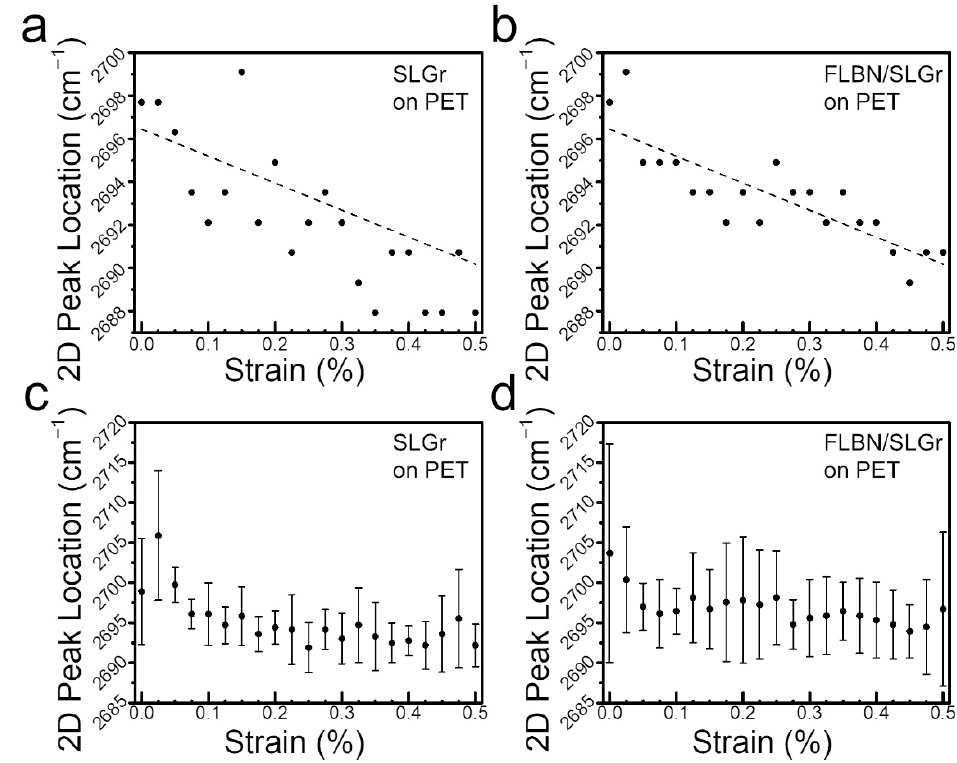
Figure 5. The evolution of the 2D bands of the prepared SLGr alone and within FLBN/ SLGr heterostructures on PET at various strains. ( a ) A representative plot of an individual SLGr 2D peak’s evolution from 0% to 0.5% strain. ( b ) A representative plot of the 2D peak’s evolution within the SLGr/FLBN heterostructure from 0% to 0.5% strain. ( c , d ) The average 2D peak location vs. strain for the entire SLGr and FLBN/SLGr heterostructure, respectively. The error bars correspond to one standard deviation away from the mean.